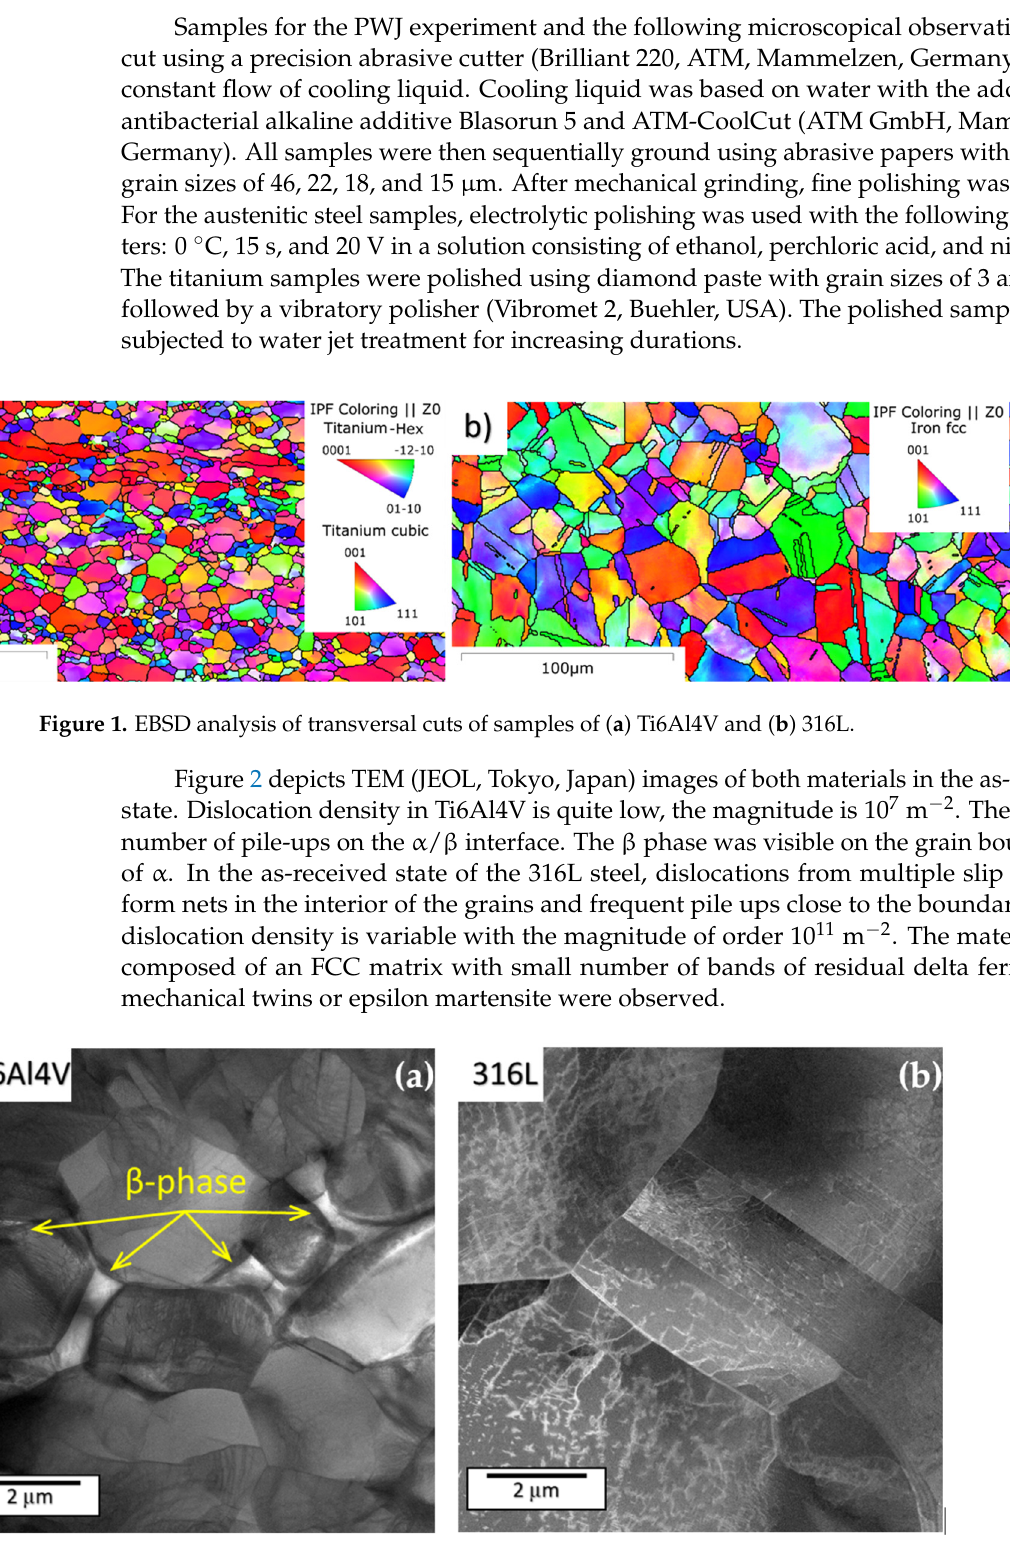
Figure 2. TEM observation of as-received ( a ) Ti6Al4V and ( b ) 316L.